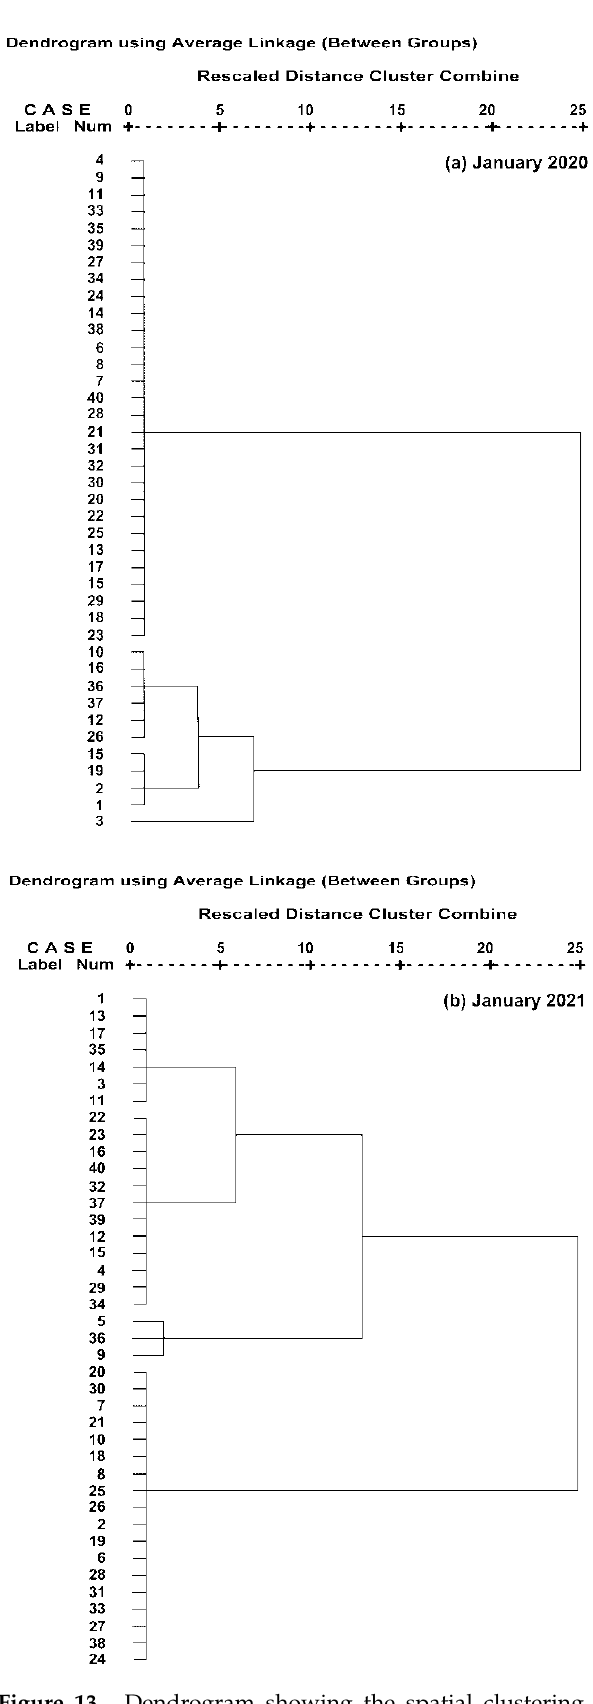
Figure 13. Dendrogram showing the spatial clustering of samples for ( a ) January 2020 and ( b ) January